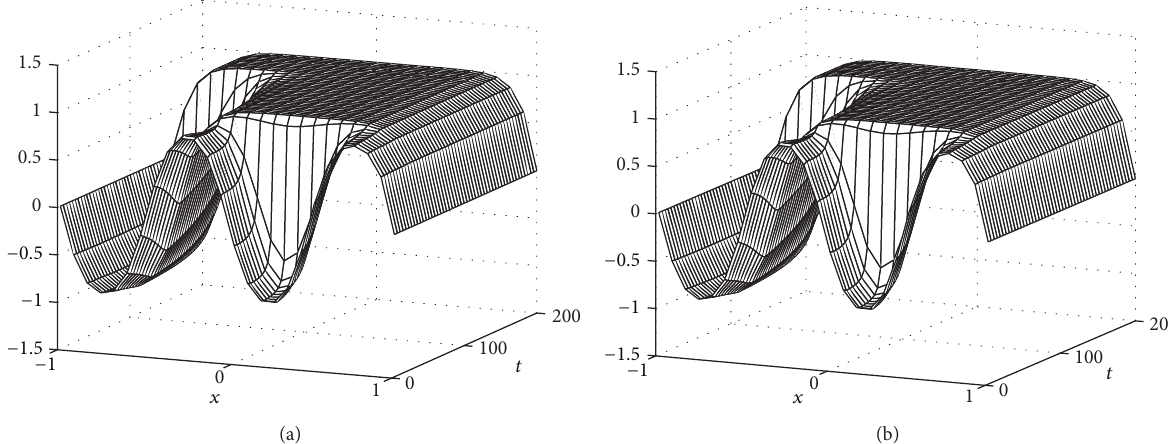
Figure 2: The numerical solutions of the Allen-Cahn equation at 𝑡 ∈ [0,200] obtained by the two methods with 𝑁 = 100 and 𝜀 = 0.01 .